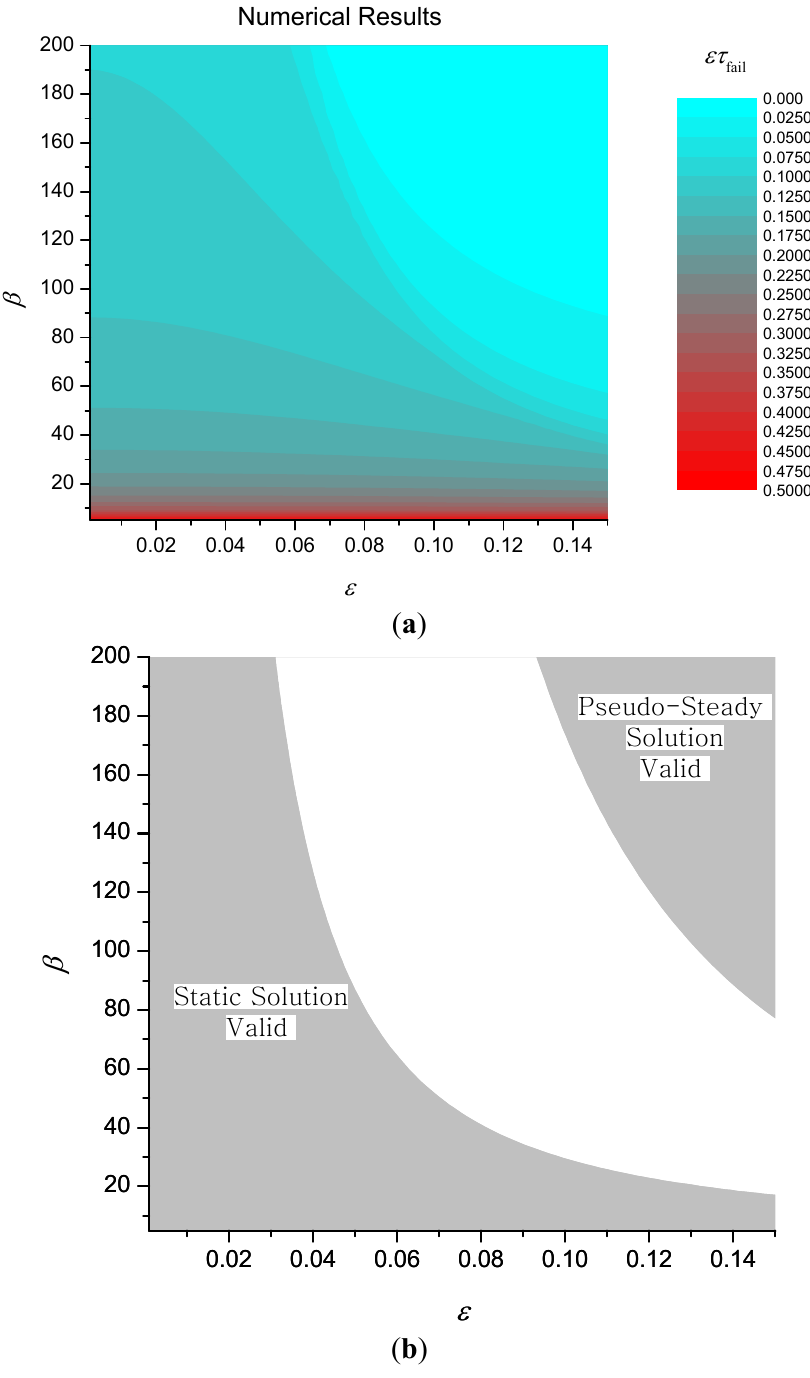
Figure 8. Contours of ετ fail ( a ) and validity of approximate solutions for simple expanding char model ( b